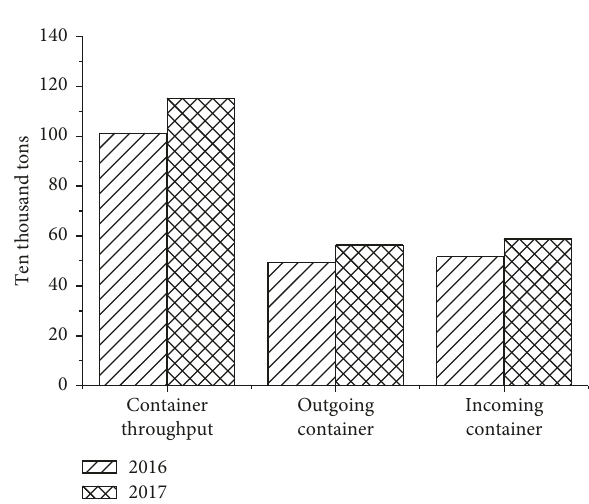
Figure 3: Bar chart of container throughput.